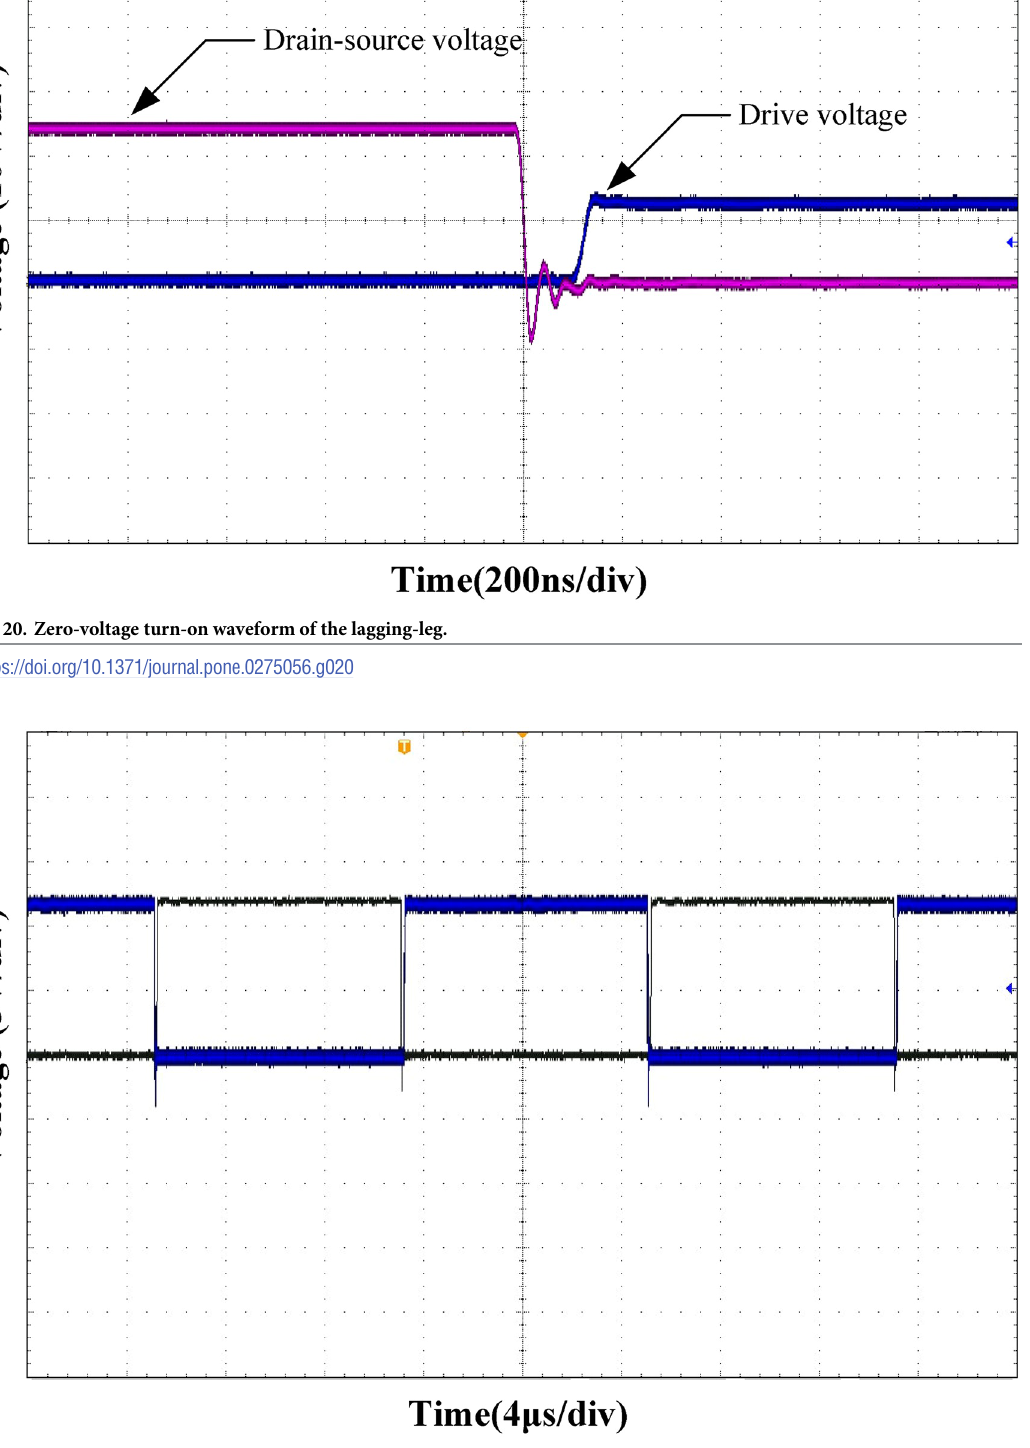
PLOS ONE | https://doi.org/10.1371/journal.pone.0275056 September 22,